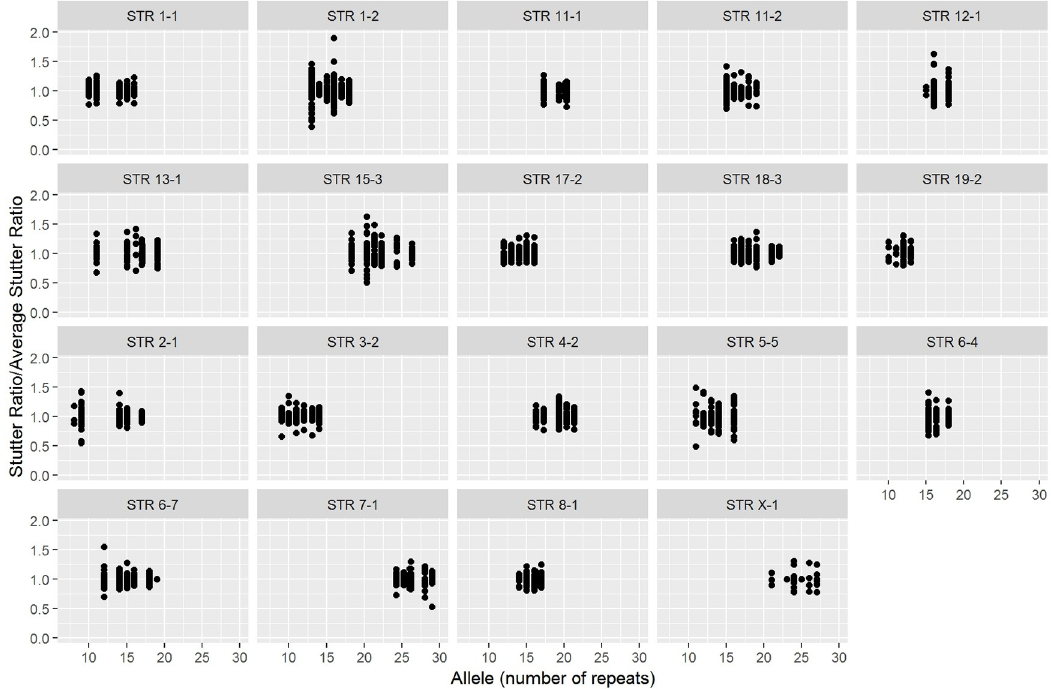
Fig 2. Normalizing stutter across alleles. The y-axis shows each observed stutter ratio divided by the average of all stutter ratios observed for the same marker and allele. The x-axis shows the allele number (number of repeats).